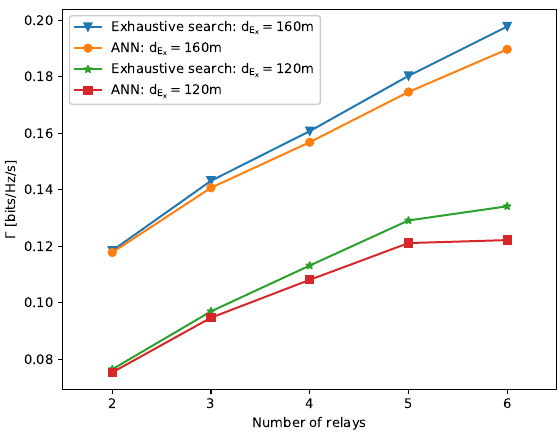
Figure 5. The achievable secrecy rate for different number of relays.